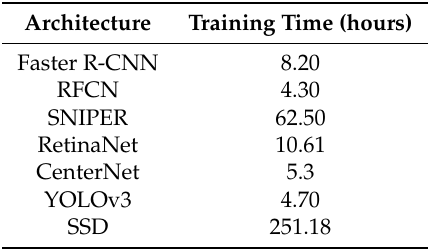
Table 2. Training time of Faster R-CNN, RFCN, SNIPER, RetinaNet, YOLOv3, SSD with VisDrone2018 on GeForce RTX 2080 Ti GPU.